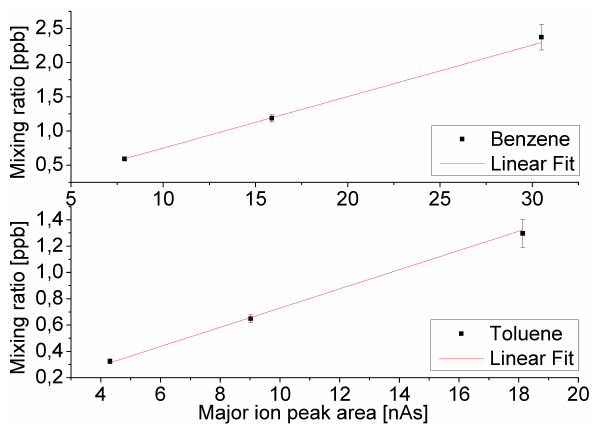
Fig. 5. Isotope ratios of benzene and toluene versus major ion peak areas for three dilution steps of standard B; each data point is an average of four to six measurements. The error bars of the isotope ratios represent the standard deviations. Error bars of the peak area are not shown, since they are not relevant for the constant fit.